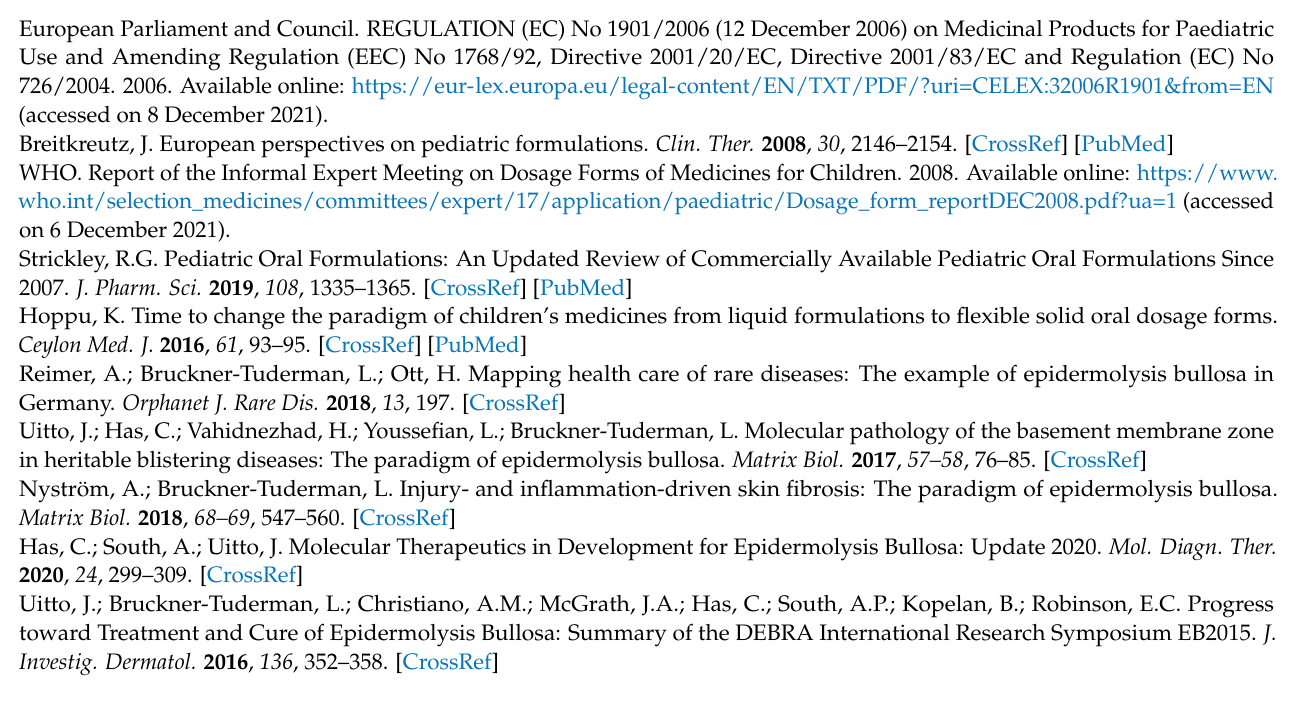
Table S4: Purity of the coated mini-tablets (F 10C) stored at 40 ◦ C/75% r.h. and 25 ◦ C/60% r.h. in different packaging conditions (openly, in polyethylene bags (PE), and in sealed aluminium foil (Alu)). For better overview, only results at the initial timepoint and after 6 months of storage are shown (3rd-month timepoint not shown) (MT = mini-tablets, ND = not detected, <0.1% = impurities detected but not included in calculations), Table S5: Purity of the coated mini-tablets (F 11) stored at 40 ◦ C/75% r.h. and 25 ◦ C/60% r.h. in different packaging conditions (openly, in polyethylene bags (PE), and in sealed aluminium foil (Alu)). For better overview, only results at the initial timepoint and after 6 months of storage are shown (3rd-month timepoint not shown) (MT = mini-tablets, ND = not detected, <0.1% = impurities detected but not included in